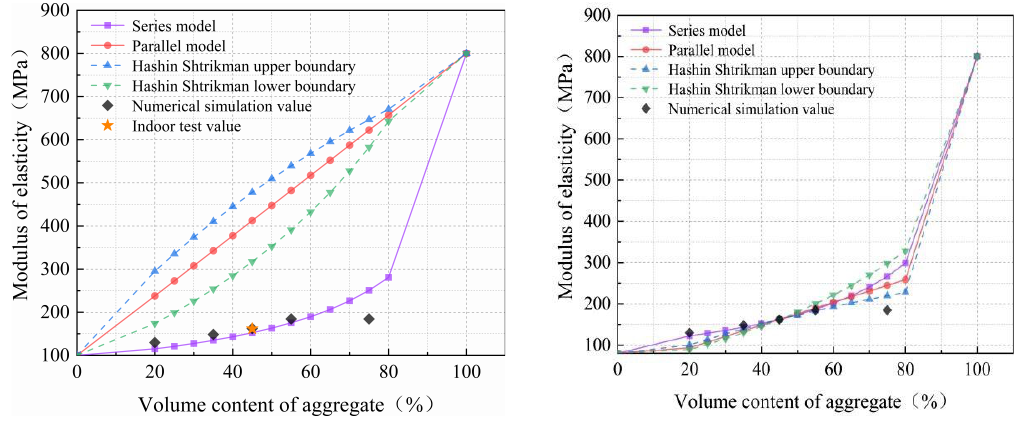
Figure 7: Prediction value of effective elastic modulus of different aggregate volume ratio and its